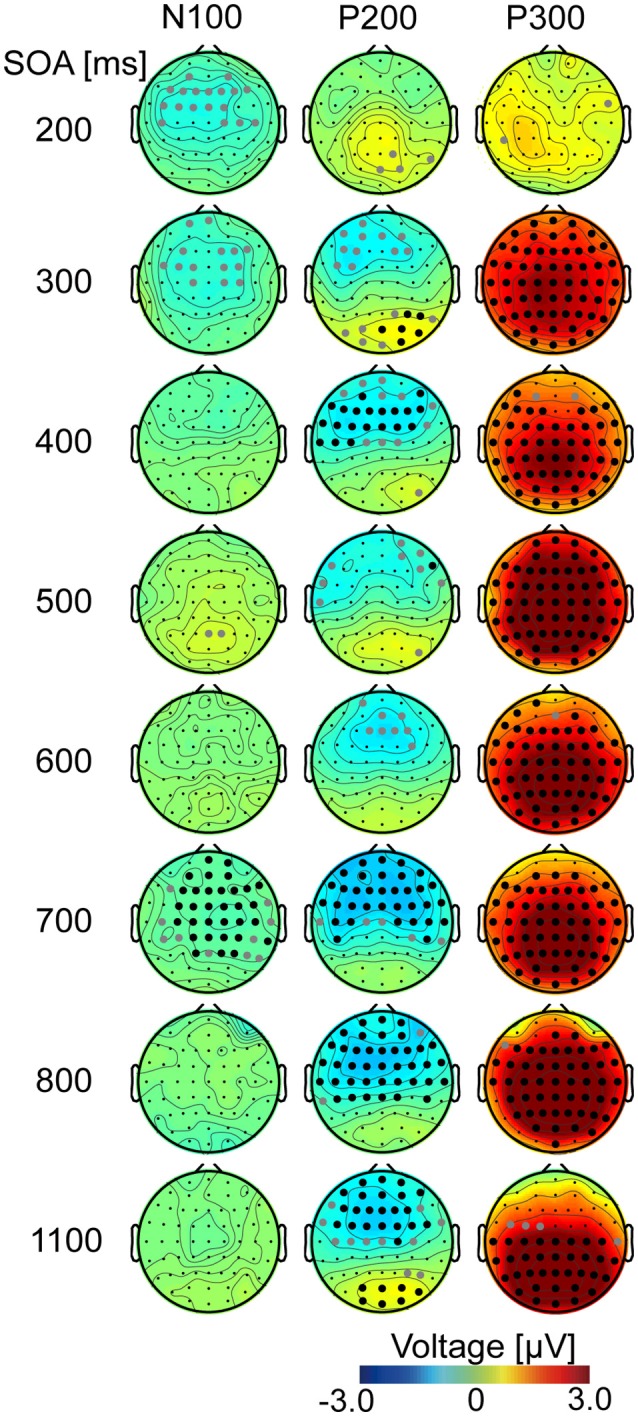
Topography of ERP difference (target – non-target). Differences in ERPs were calculated from averaged EEG data for all participants. Each row represents one of the eight SOA conditions and shows difference maps at each latency for N100, P200, and P300 (Supplementary Table 1). White and gray filled circles represent channels that showed statistically significant differences (p < 0.05) with and without FDR correction, respectively.